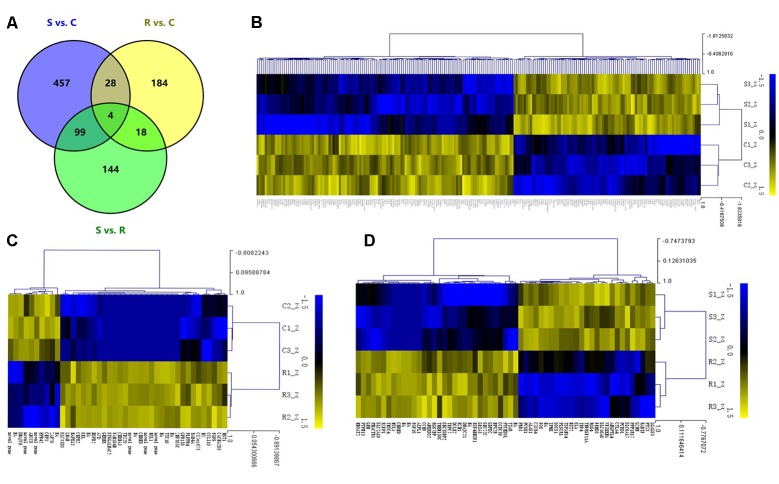
Different expression profiles of unique mRNAs in host immune response to SE infection. (A) Venn diagram shows the overlap of DEGs among the 3 groups; numbers are the DEGs in each comparison. (B–D) The heat map of unique DEGs in S vs. C, R vs. C, and S vs. R, respectively (FC > 2 and FDR < 0.05). S, challenged-susceptible; R, challenged-resistant; C, non-challenged controls.